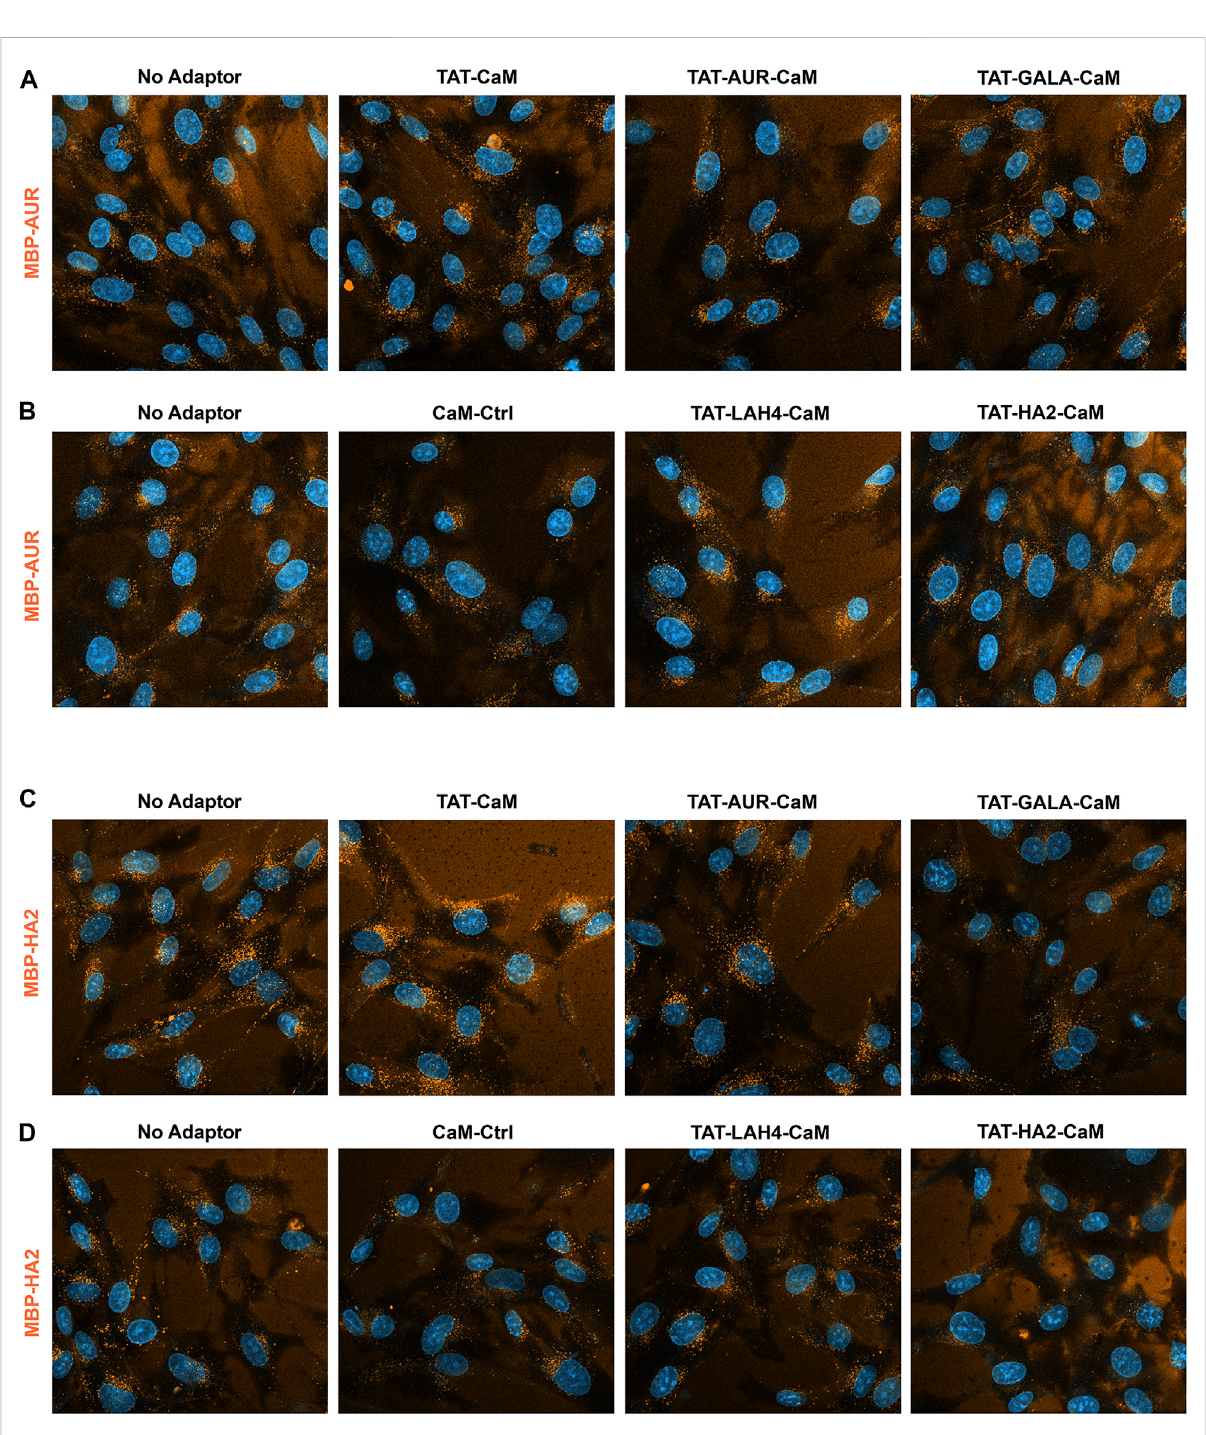
FIGURE 9 550-MBP-AUR and 550-MBP-HA2 internalized with adaptor set including controls as in prior 2 fi gures. Equimolar adaptor/cargo complexes (1 µM)wereinternalizedingrowth mediafor 1 hprior towashing(PBSx2)and imaging inmediacontainingNucBlue. InternalizationofMBP-AURand MBP-HA2 with theadaptors asabove inboth theupperpanels (A,C) andthelower panels (B,D) .For presentation, intensities within eachset adjusted identically but with the no-adaptor reference at approximately equal intensity for all